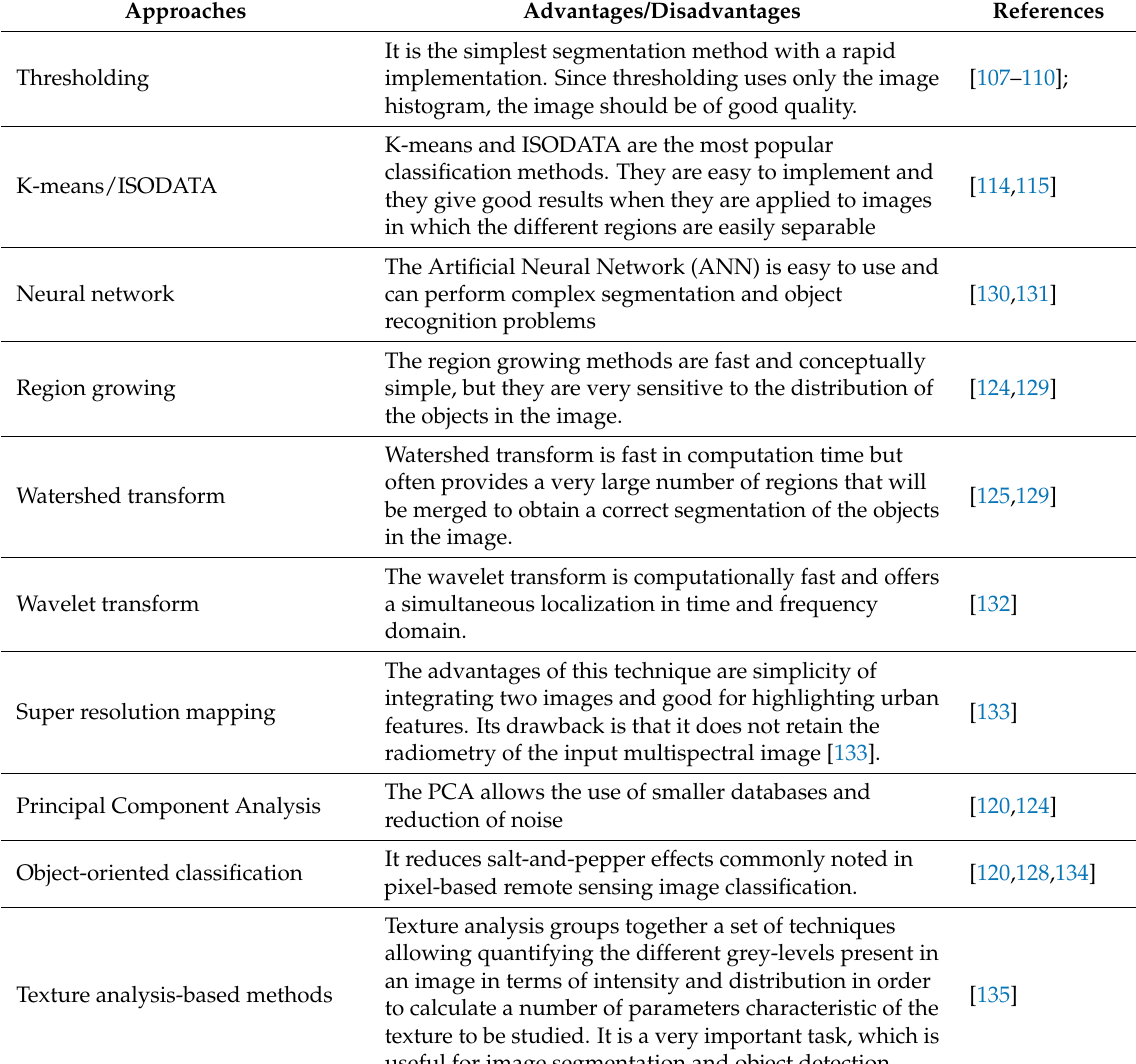
Table 6. Summary of segmentation